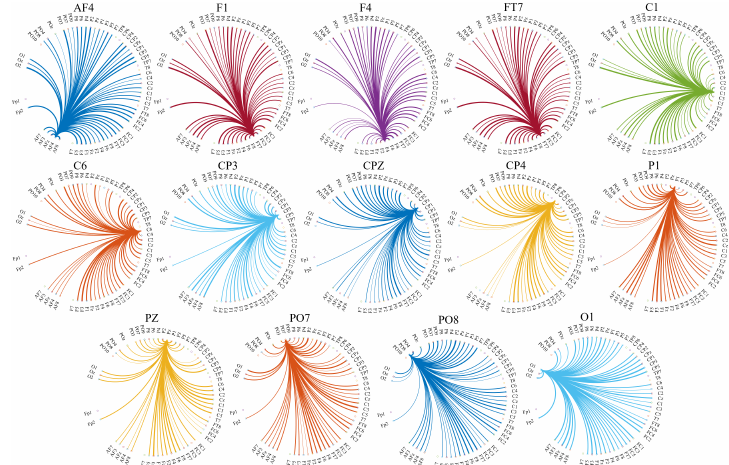
Figure A7. Eyes-Open (EO) setting. Transfer of information from (i.e., out-degree) AF4, F1, F4, FT7, CP3, CP4, CPZ, C1, C6, P1, PZ, PO7, PO8, and O1 to the other cortical regions in the case of LOW stress-susceptible group. In each subplot, the source of information transfer (e.g., AF4,F1, etc.) is the one from which all connections are originated. They are labeled at the top of each subplot. The recipients of information (i.e., channels on the other cortical regions) are the ones at the other end of these outreaching